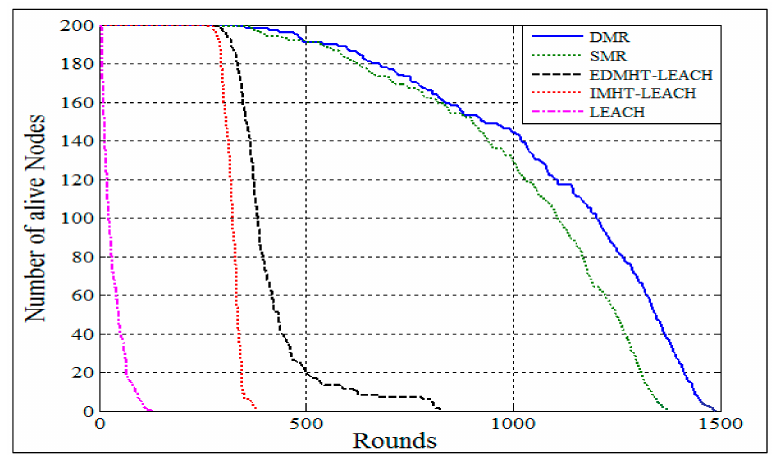
Figure 11. The comparison of the number of alive nodes in the DMR, SMR, EDMHT-LEACH, IMHT-LEACH and conventional LEACH